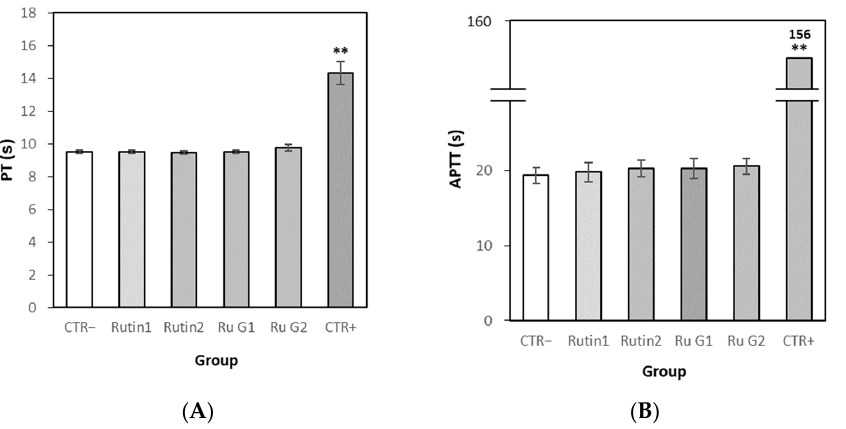
Figure 10. PT ( A ) and APTT ( B ) of PPP in vivo . Each time point represented the mean + S.E. n = 8 (G2, n = 4). CTR − means normal control, CTR+ means positive control (heparin), Ru G means rutin glycoside. Significant differences from the normal control group were determined via Independent t -test (** p < 0.01). No statistically significant differences were noted in the substance groups from the normal control group ( p >